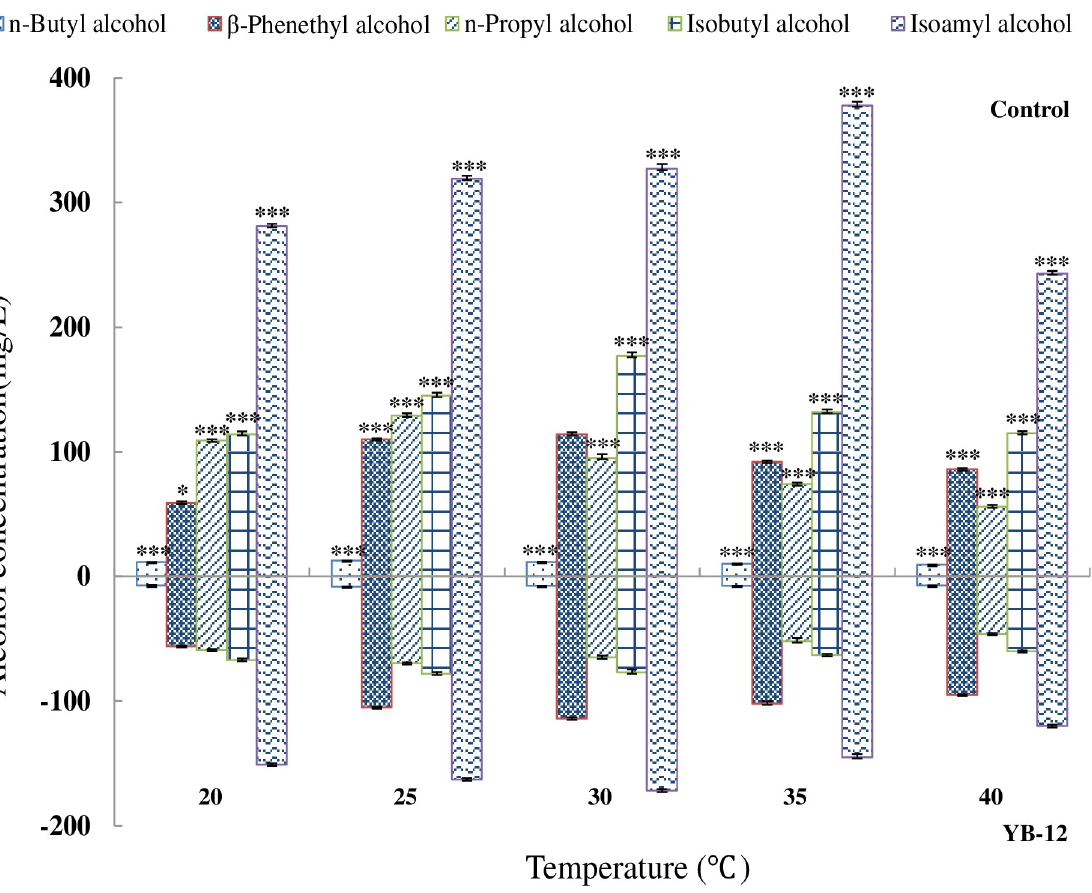
Fig 4. Effect of the fermentation temperature on FA production by the reference strain (A) and yeast YB-12 (B). Significance levels: � , P = 0.05; �� , P = 0.01; ��� , P =